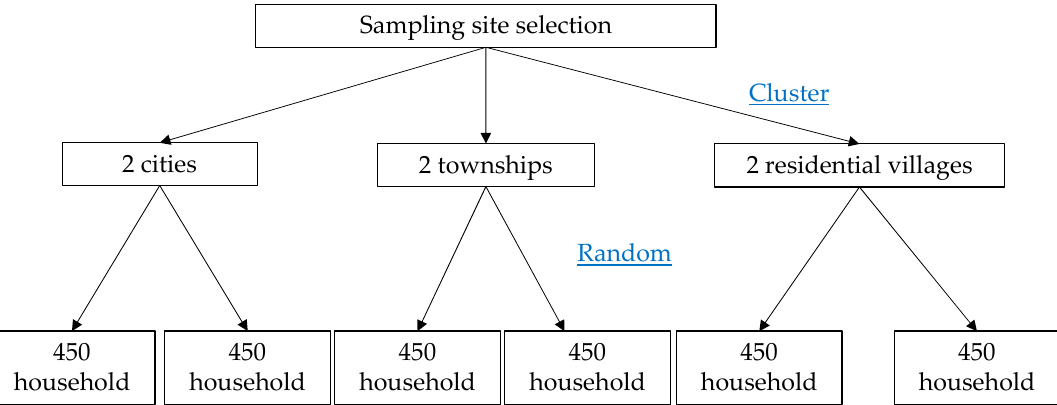
Figure 1. Flow chart of the sampling process.